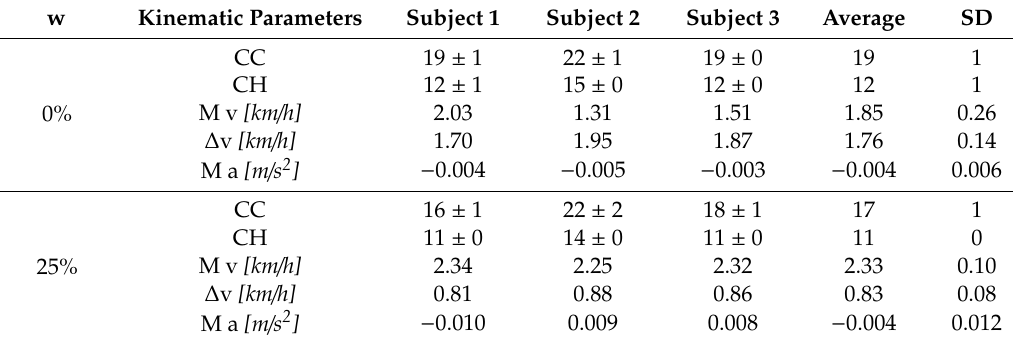
mode Table 3. List of average values of the analyzed kinematic parameters for the hill-climbing assistance mode (t3).